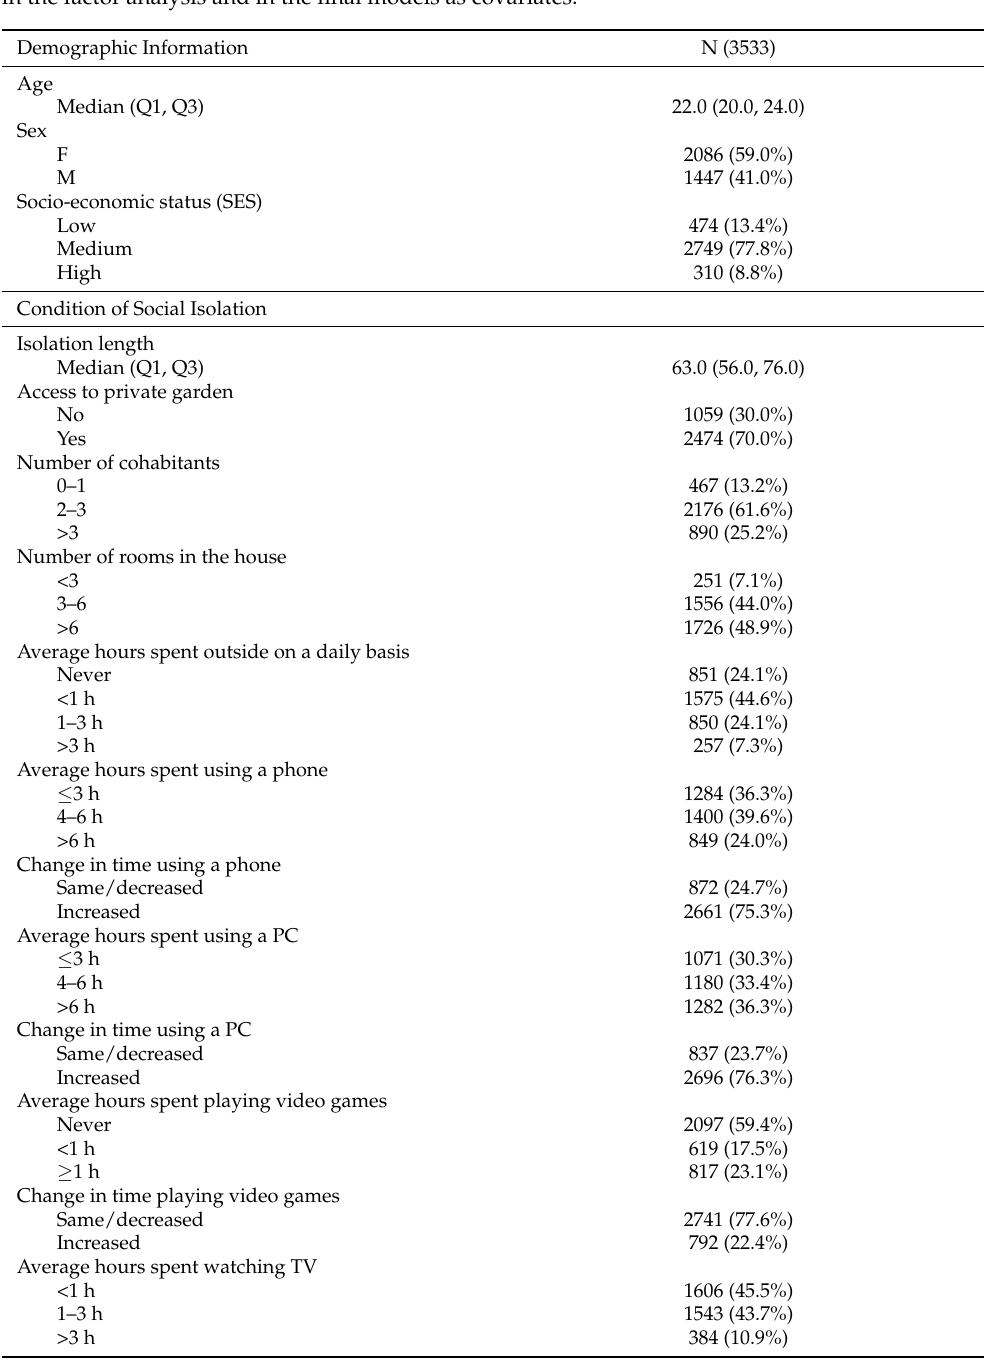
Table 1. Descriptive statistics of the overall 3533 participants in the survey for the variables included in the factor analysis and in the final models as